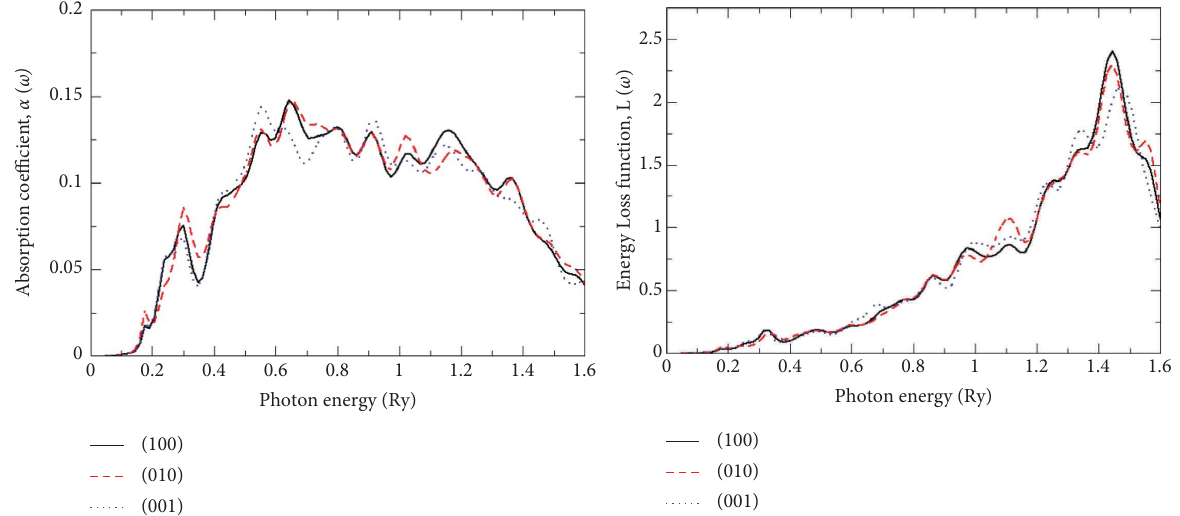
Figure 10: Te optical absorption coefcient and energy loss function for CaHfS